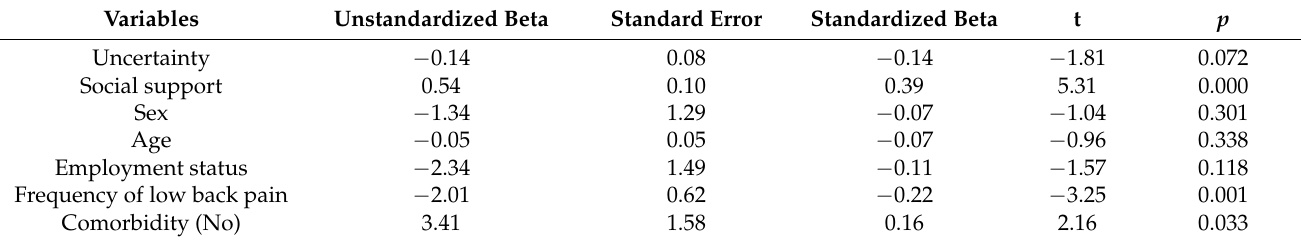
Table 5. Multiple linear regression of quality of life (n =